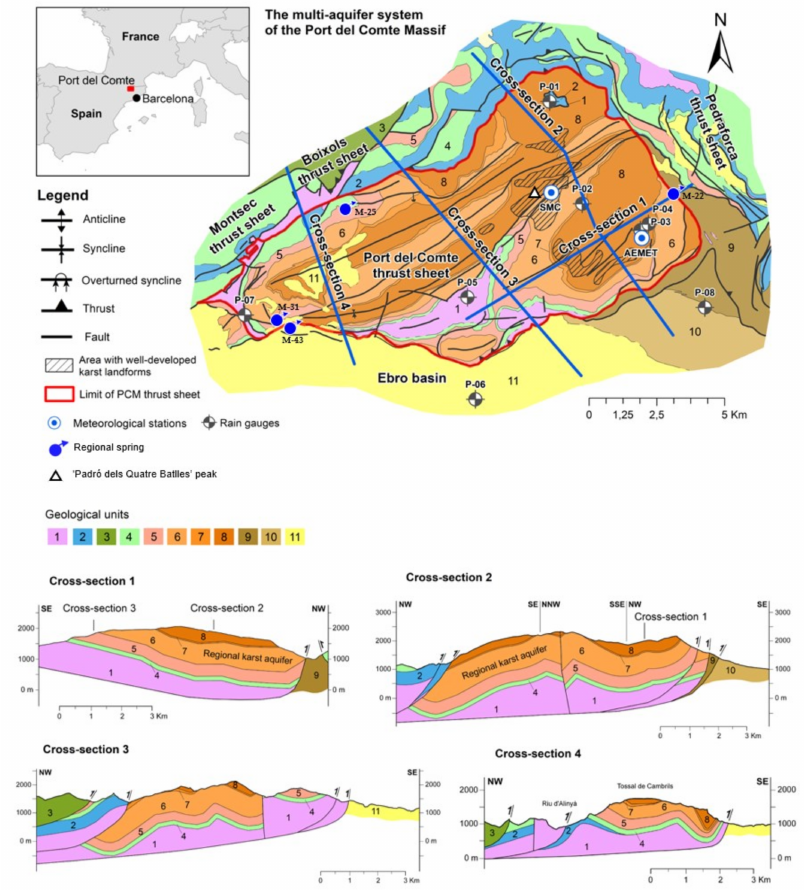
Figure 1. Geological setting of the Port del Comte massif. (1) Triassic: shales, limestones, dolomites, and evaporites (Tk, Tm); (2) Jurassic: marls, bioclastic limestones and dolomites (TJb, TJcd); (3) Lower Cretaceous: micritic limestone-marl alternations; (4) Upper Cretaceous: limestone-marl alternations and calcarenites (Kat, KMca); (5) Garumnian (Upper Cretaceous-Lower Paleogene): shales, marls and limestone (Kgp), multicoloured ‘redbed’ facies clay deposits; (6) Lower Eocene: fissured/karstified alveoline limestones and dolostones (PPEc), and includes colluvial Quaternary formations that partially overlap (Qpe, Qvl); (7) Lower Eocene: marls, sandstones, and limestones (PEci); (8) Lower Eocene: fissured/karstified micritic and bioclastic limestones (PEcp1, PEcp2); (9) Middle Eocene: sandstones, marls, conglomerates, limestones, and evaporites (PEalb, PEm1, PEmb and PExb), including colluvial Quaternary deposits (Qcoo) and alluvium (Qoo) that partially overlap; (10) Upper Eocene: alluvial systems: conglomerates and sandstones; and (11) Oligocene alluvial system: conglomerates and breccias deposits and sandstones (POcgs, POmlg). The breccia deposits covering the Lower Eocene in the upper part of the massif are very thin. The epigraphs in parentheses correspond to the geological units [41] where the springs included in this work are located (modified from Herms et al.,